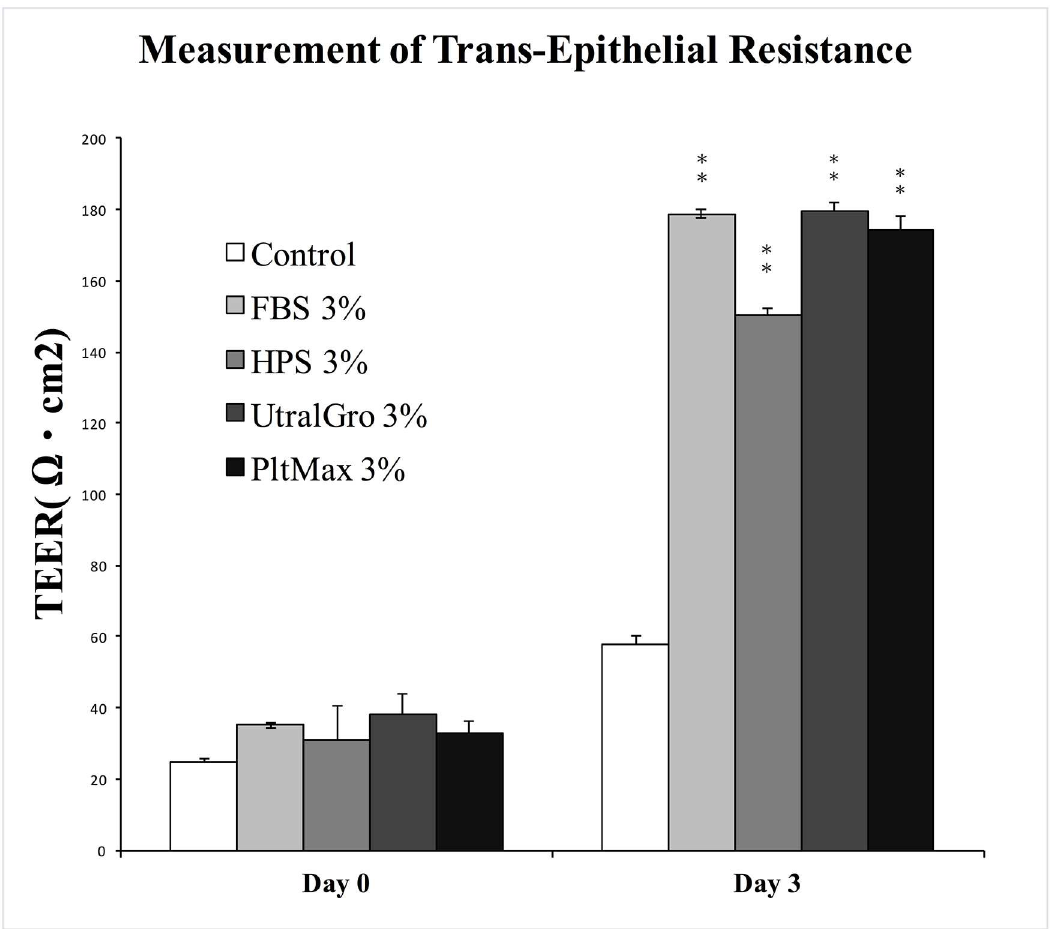
Fig 4. Cell differentiation: Measurement of trans-epithelial electrical resistance (TEER). The effects of different blood derivatives on trans-epithelial electrical resistance. Cells incubatedwith fetal bovineserum (FBS), humanperipheral serum (HPS), UltraGRO humanplatelet lysate (HPL), and PLTMax HPL demonstrated significantly higherTEER values comparedto the control group. However, there was no significantdifferencesamong FBS, HPS, UltraGRO, and PLTMax on day 3 after the cells reachedconfluency. UltraGRO: Human platelet lysate from Helios pharmaceutical. PLTMax: Human platelet lysate from Mill Creek pharmaceutical. * indicatedp < 0.01. ** indicatedp < 0.01 comparedto the control group that was without any blood